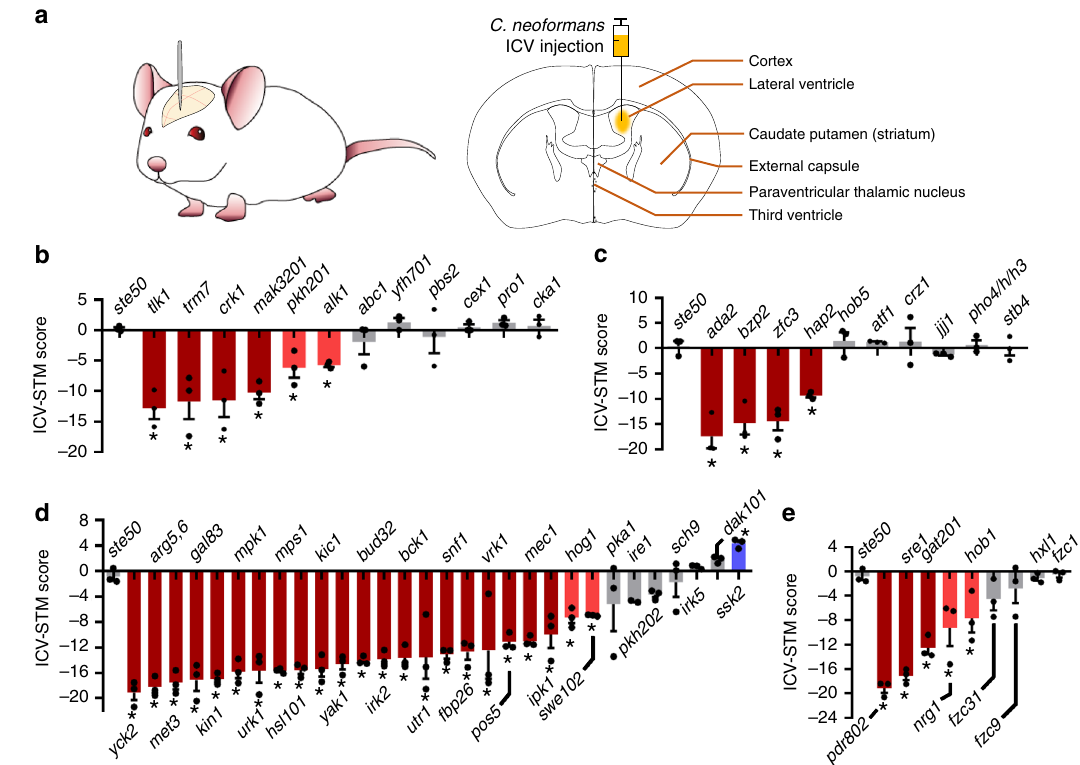
Fig. 4 Identi fi cation of genes required for survival of C. neoformans in the brain parenchyma through intracerebroventricular (ICV)-STM analysis. ( a ) Graphical abstract of ICV injection for directly infecting the brain parenchyma with C. neoformans . ( b – e ) ICV-STM score of brain-infection-related ( b ) kinases, ( c ) TFs, core-virulence ( d ) kinases, and ( e ) TFs. Three mice (A/J) were infected with each pooled mutant group (Supplementary Data 4), sacri fi ced after 7 dpi, and infected brain tissues were harvested for recovering cryptococcal cells. The ICV-STM score was calculated by quantitative PCR of genomic DNA isolated from input and output cryptococcal mutants as described in Methods. The ste50 Δ mutant was used as a virulent control strain. Red and blue marks (with *) indicate mutants whose STM scores are statistically different ( P < 0.05, n = 3) from the ste50 Δ STM score by one-way ANOVA analysis with Bonferroni ’ s multiple comparison test. Data are presented as mean values ±